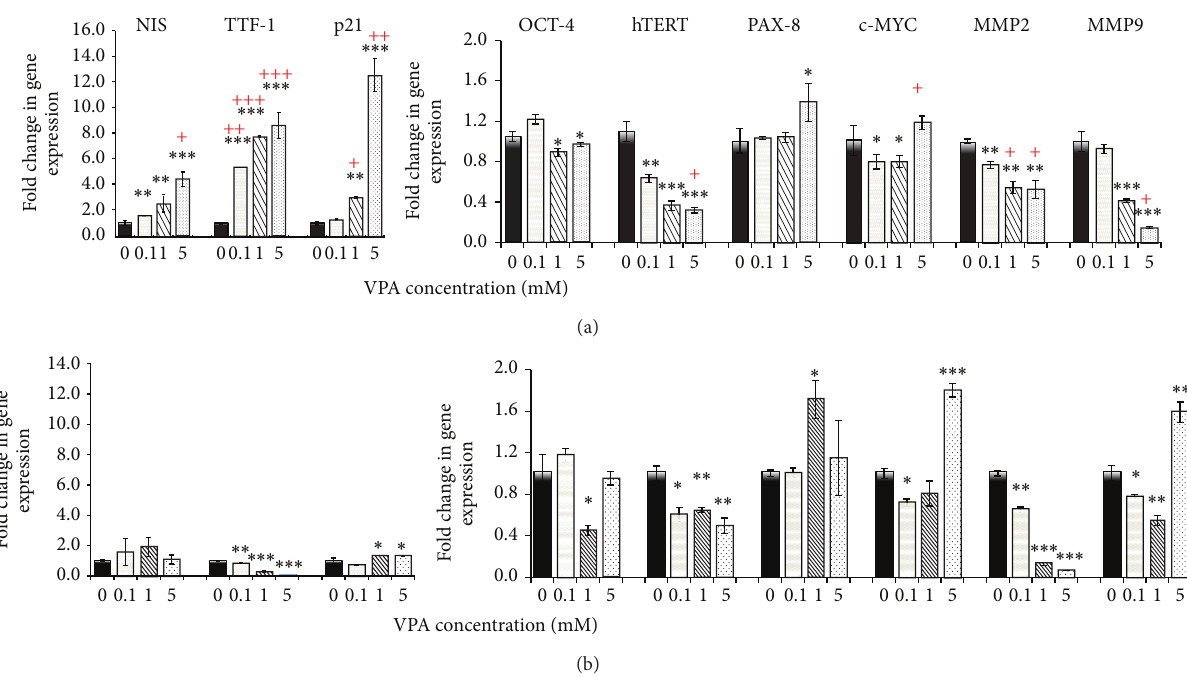
Figure 4: Effect of 96 h VPA treatment on mRNA transcriptional level. The relative mRNA expression of NIS , TTF1 , p 21, OCT-4 , hTERT , PAX8 , c-MYC , MMP2 , and MMP9 was measured following VPA treatment. The relative mRNA expression of each gene was measured by qRT-PCR in the 0.1, 1, and 5 mmol/L VPA treated 8305C (a) and B-CPAP (b) cell lines as described in Section 2. Data are presented as mean ± SD. ∗ 𝑃 < 0.05 , ∗∗ 𝑃 < 0.01 , and ∗∗∗ 𝑃 < 0.001 . + two cell lines compared to each other. Statistical significance was calculated using paired two-tailed Student’s 𝑡 -tests.